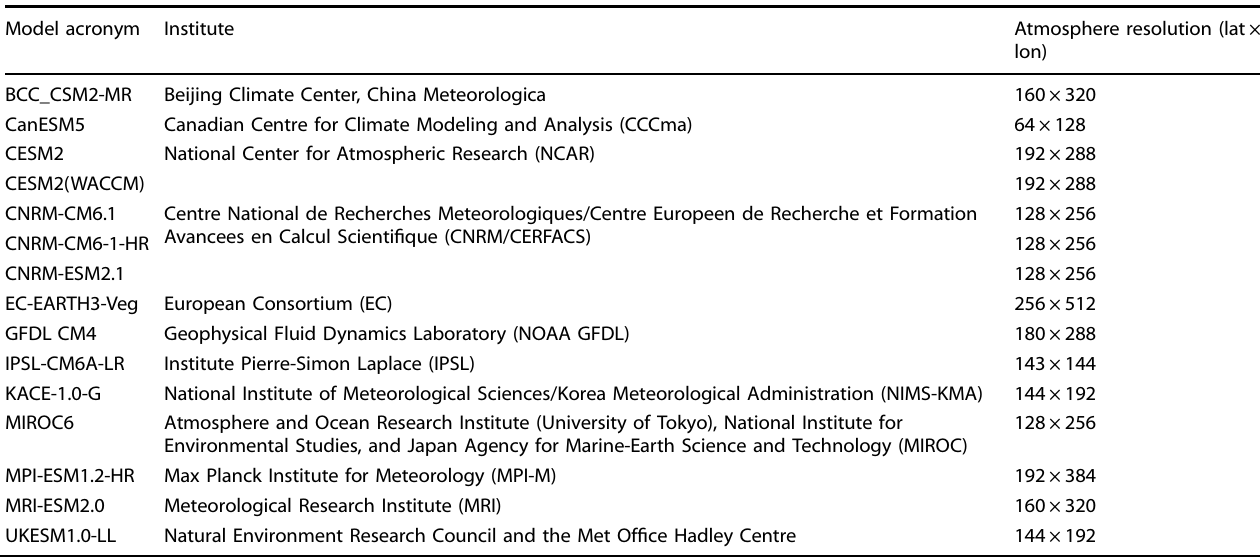
Table 1. Descriptions of 15 CMIP6 models employed in the